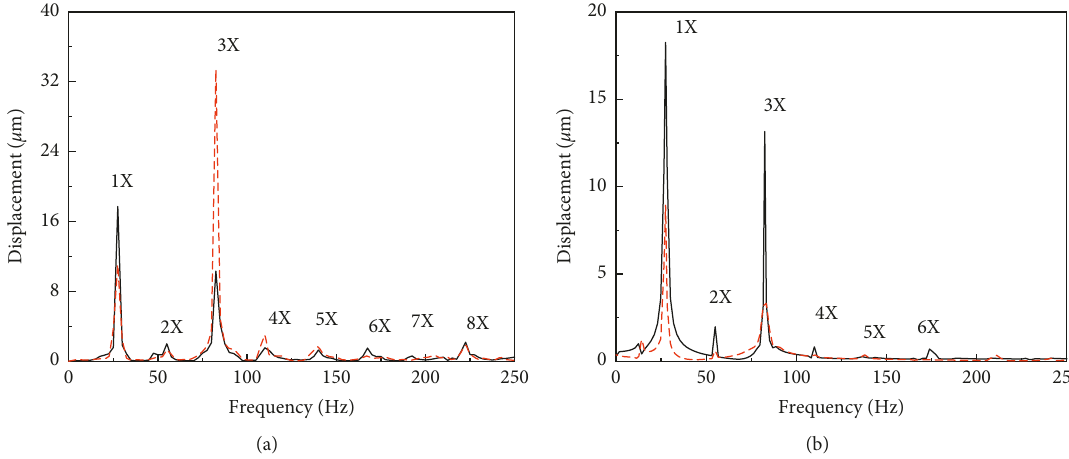
Figure 13: Comparison of dynamic response in frequency domain under heavy rub-impact condition. (a) Experimental result. (b) Numerical result.